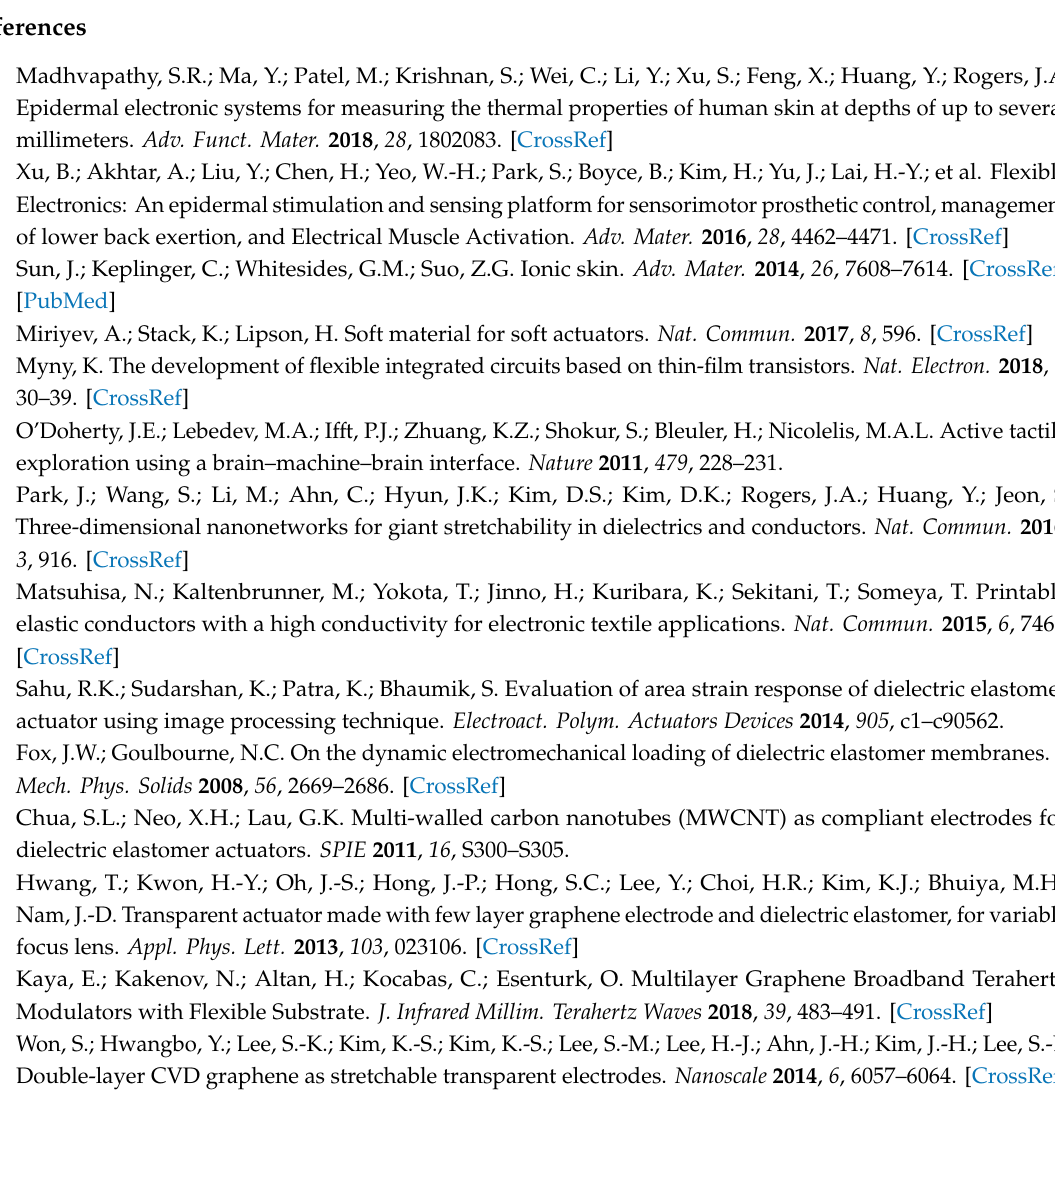
Figure S1: Schematic picture of raw materials and resultant ionogel, Figure S2: SEM images of Silica nanoparticles (SNP), Figure S3: Flexible actuator construction experiment based on SNP-reinforced ionogel and carbon grease, Figure S4: Stretchable cable based on a SNP-reinforced ionogel accessed to the light emitting diode circuit, Figure S5: SNP-reinforced ionogel flexible wire accessed to the audio signal line, Figure S6: Transmission spectrum images of SNP-reinforced ionogels, Figure S7: Optical microscope photos for 0.5 wt% SNP ionogel, Figure S8: Stretching stretchable cables based on the SNP-reinforced ionogels in audio signal line, Table S1: The conductivity of ionogels with di ff erent cross-linking degree, Video S1: A stretchable wire for a LED series circuit, Video S2: Stretchable wires for audio signal